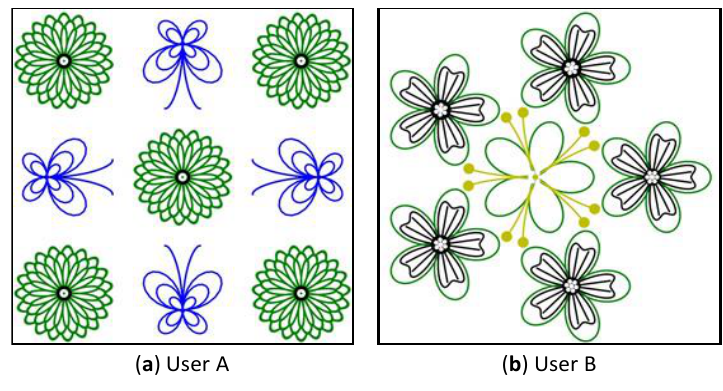
Figure 16. User-generated patterns.